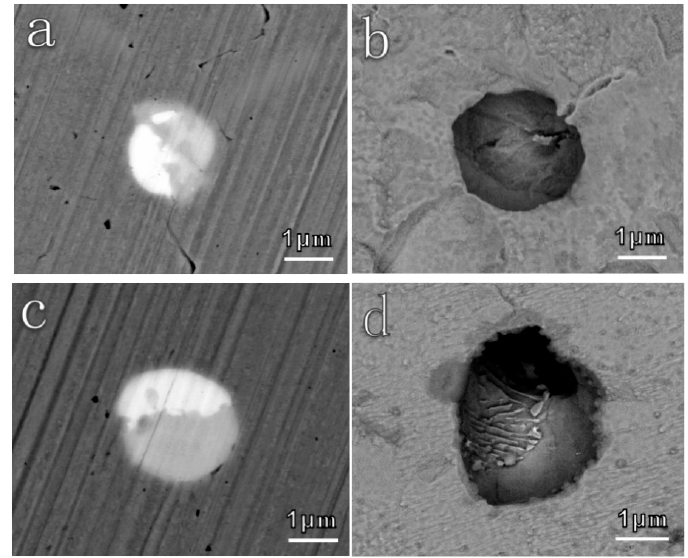
Figure 9. In-situ dissolution morphologies of inclusions in ( a , b ) Al deoxidized steel and ( c , d ) Ti/Zr deoxidized steel after immersion in 0.5 wt.% NaCl solution for 30 min. The left is before corrosion, and the right is after